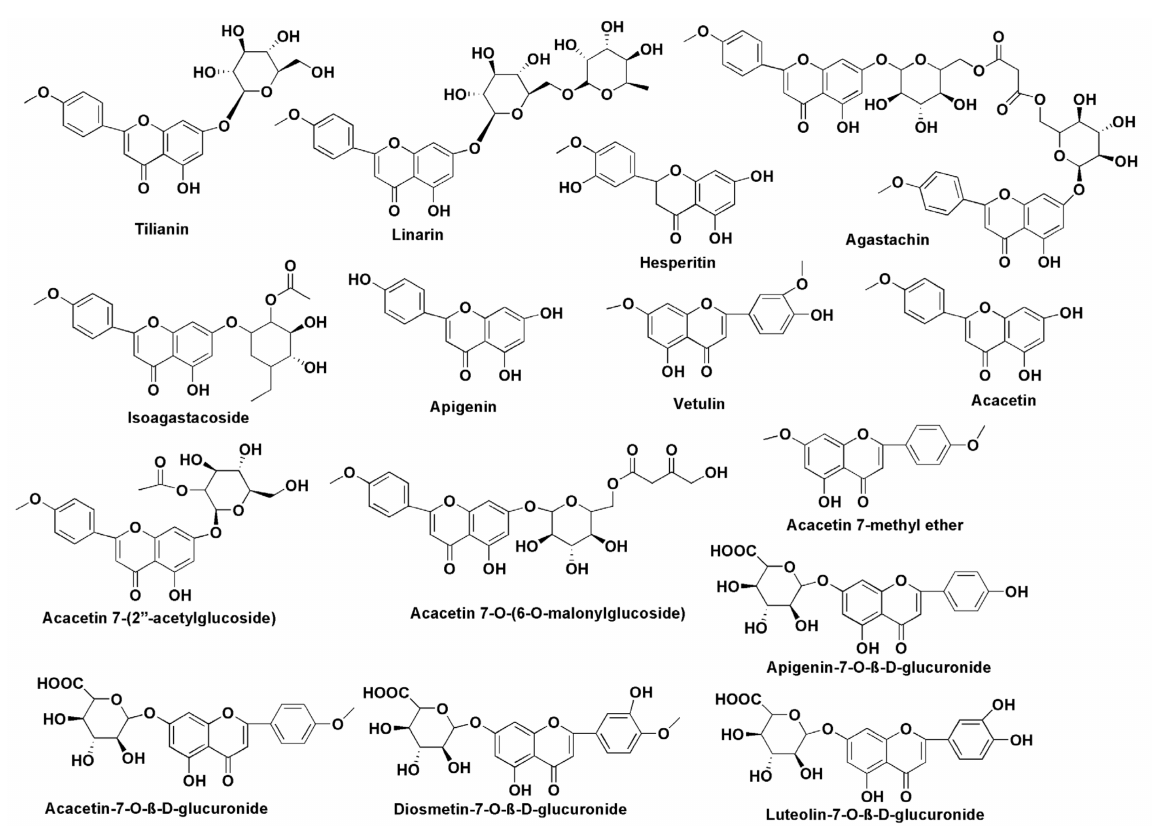
Figure 8. Chemical structure of tilianin derived/related